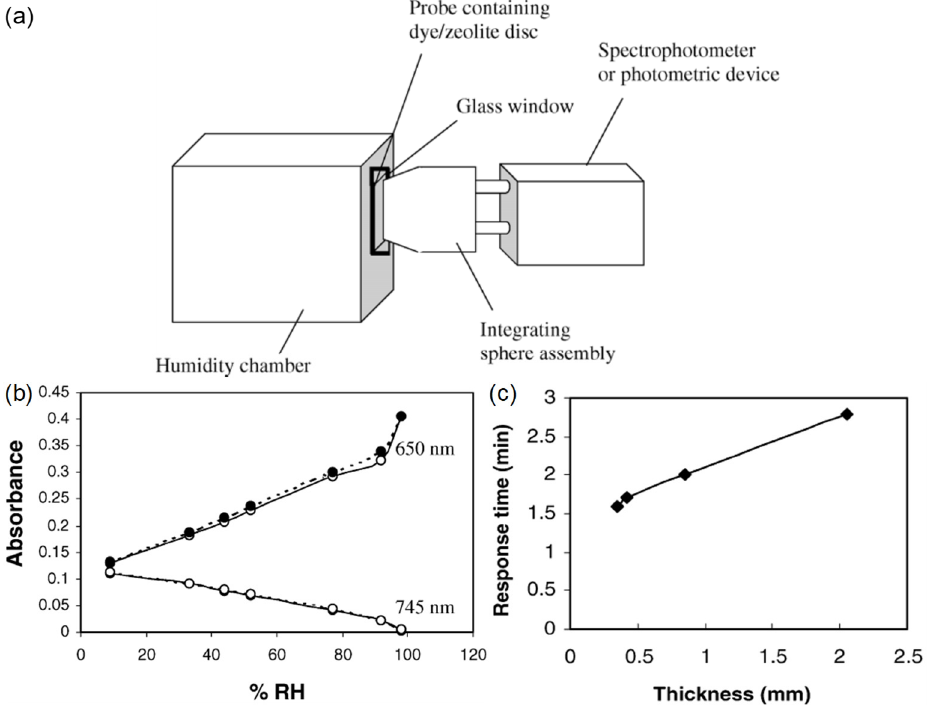
Figure 9. Point sensor. ( a ) Experimental setup. ( b ) Relationship between absorbance and RH. ( c ) Thickness-dependent response time between 9%RH and 98%RH at 650 nm wavelength. Reprinted with permission from ref. [38]. Copyright 2005 Elsevier